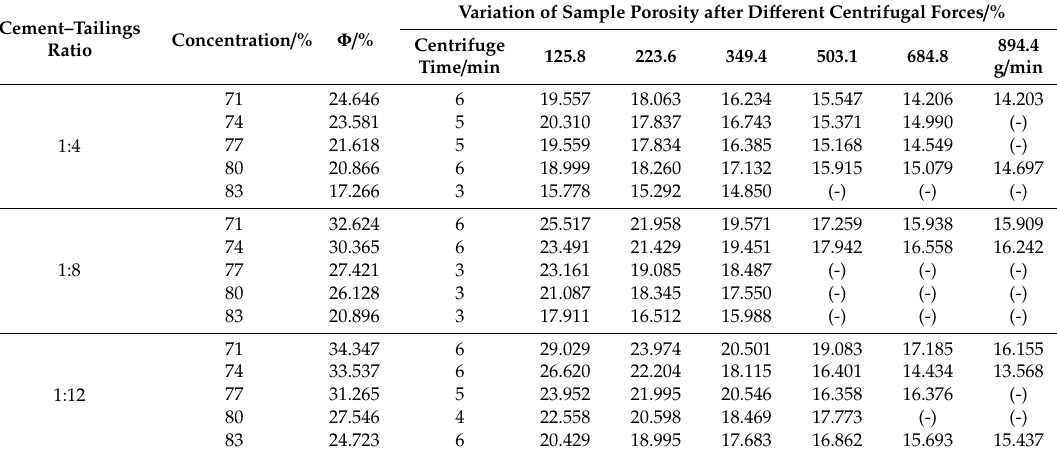
Table 3. Results of the backfill centrifugal test.